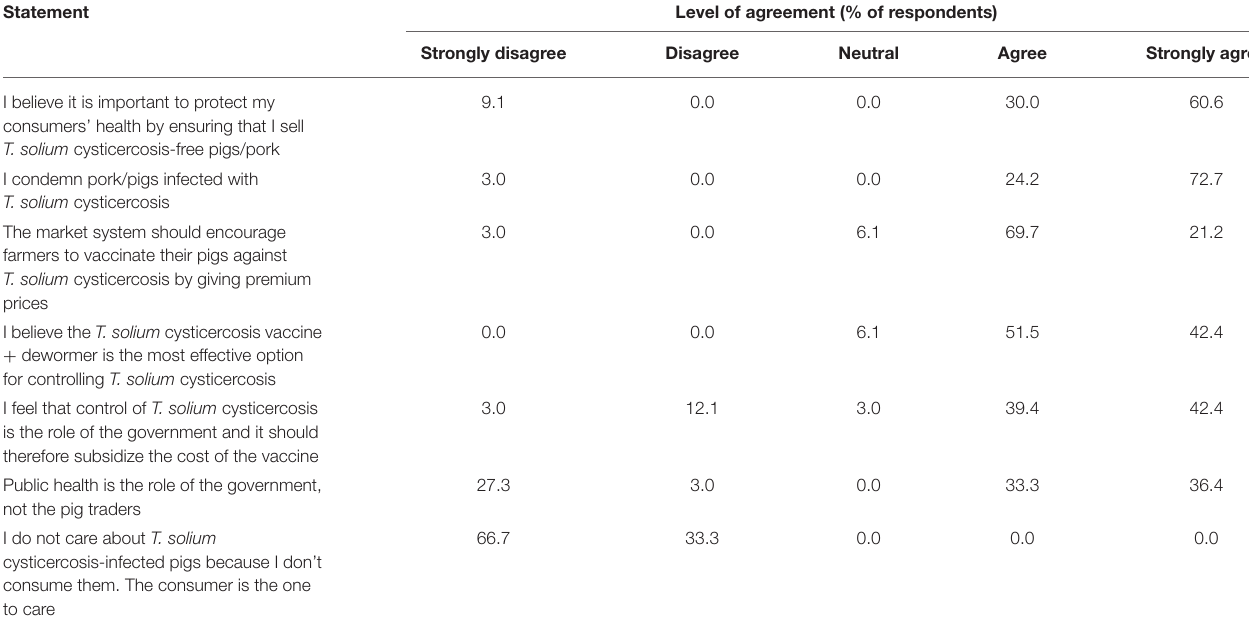
TABLE 4 | Pig traders’ perceptions on practices and roles of various actors for